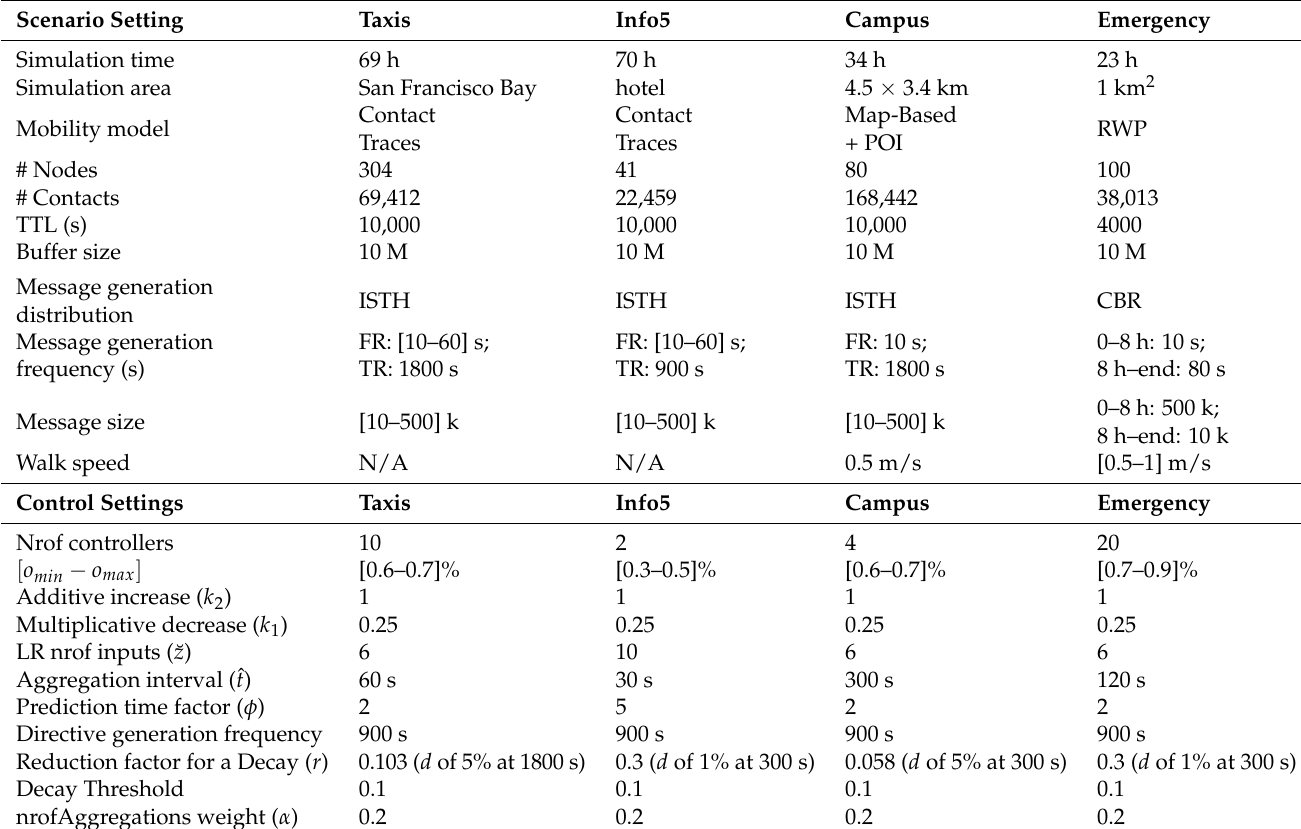
Table 3. Summary of the specific simulation settings per